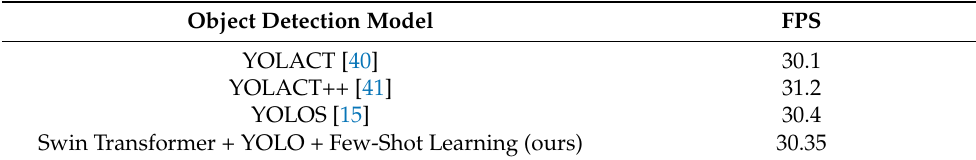
Table 4. The FPS performance evaluation